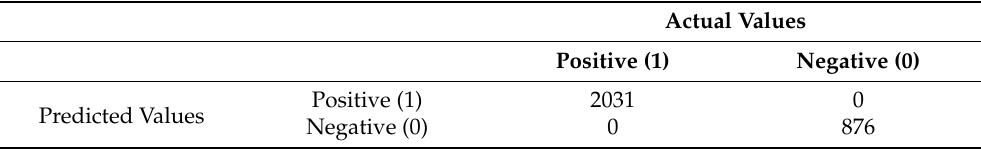
Table 9. Logistic regression confusion matrix.